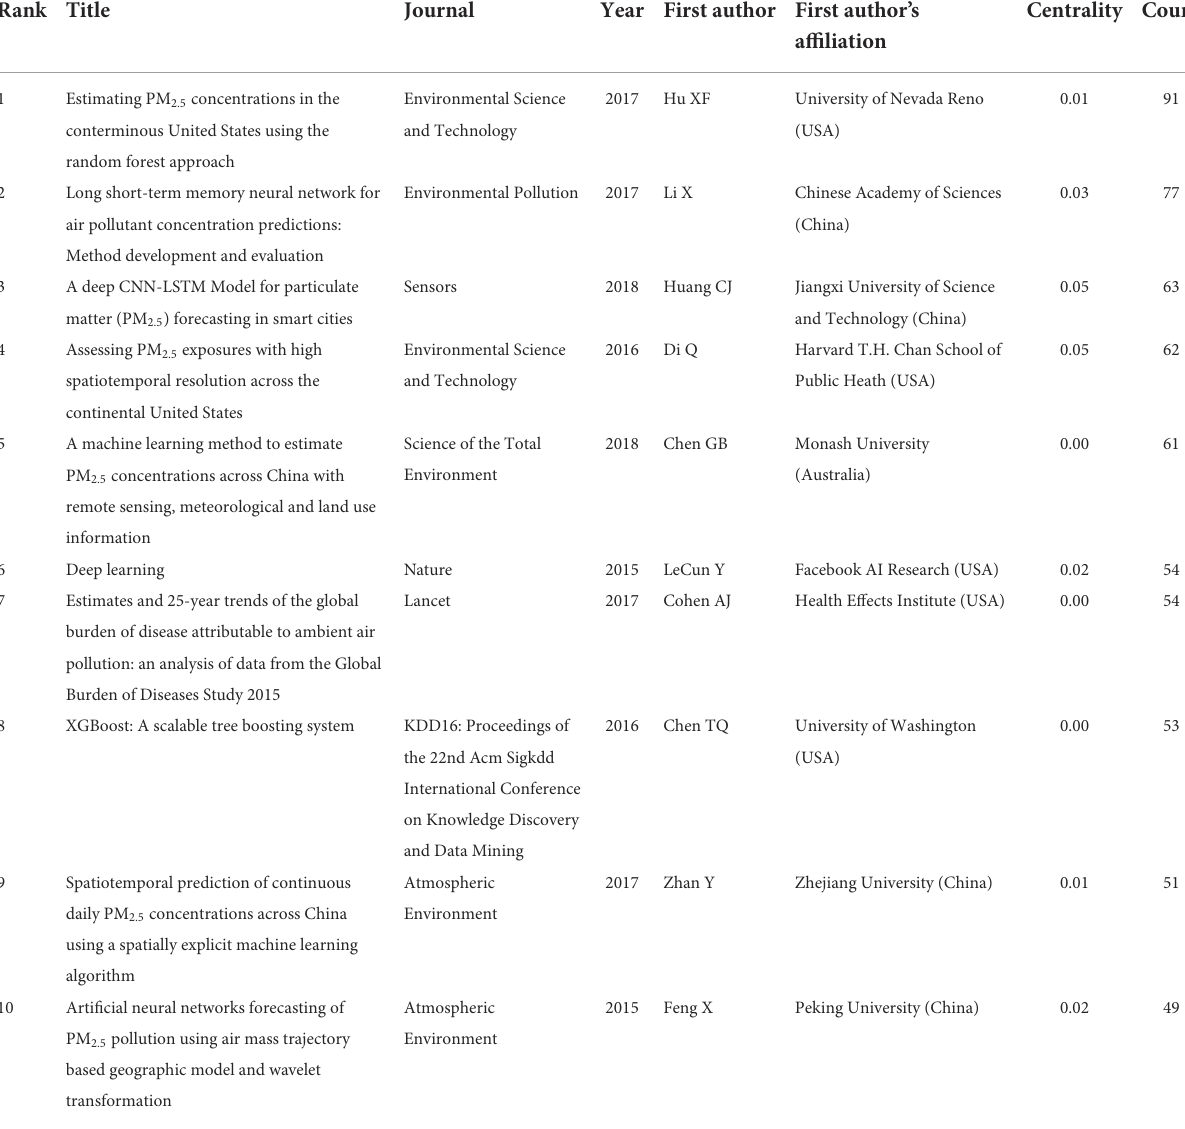
TABLE 5 The Top 10 co-cited references on artificial intelligence and air